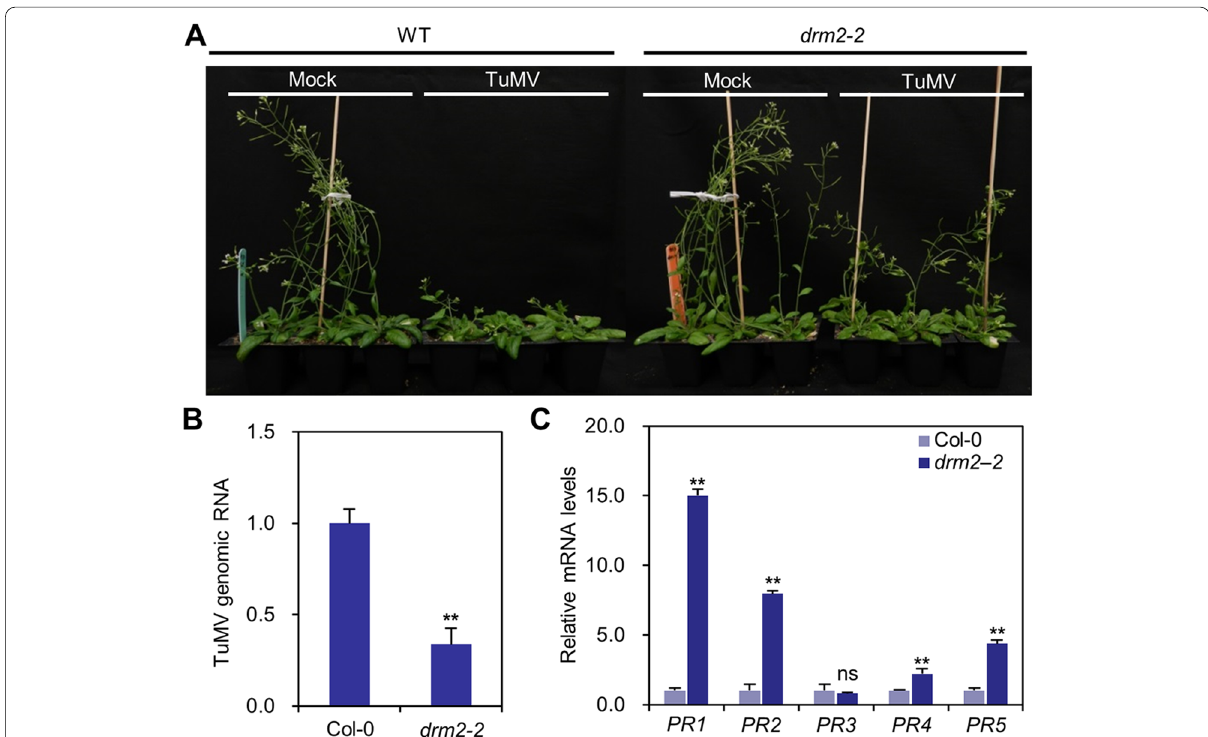
Fig. 3 The drm2–2 mutant displayed increased resistance to TuMV. A Phenotypes of TuMV-GFP on wild-type and drm2–2 mutant at 20 dpi. B Relative levels of TuMV genomic RNA in wild-type and drm2–2 mutant at 20 dpi. C Relative expression of PR1 , PR2 , PR3 , PR4 , and PR5 in wild-type and drm2–2 mutant at 20